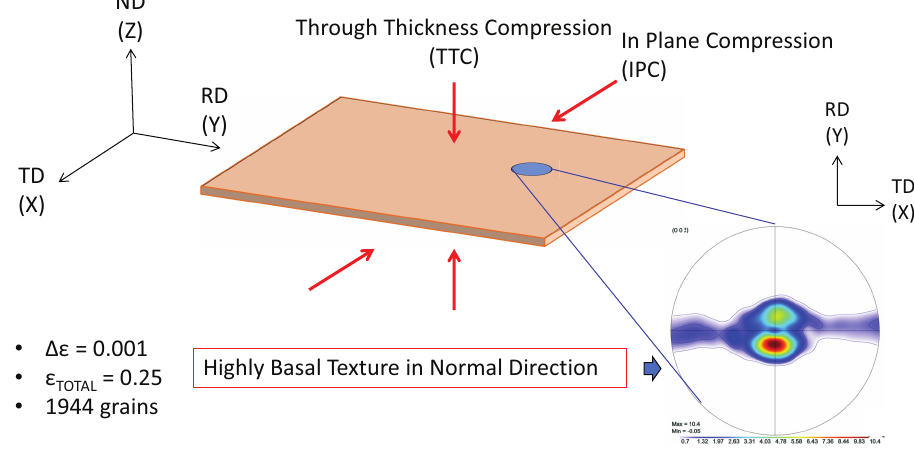
Figure 2. Simulated load paths and initial texture for simulations of rolled pure